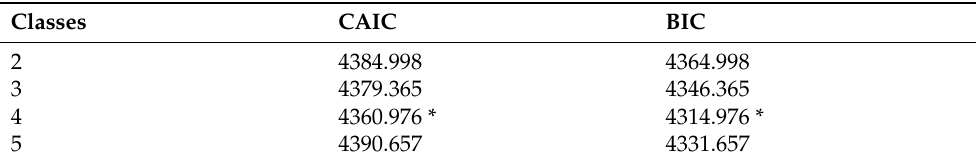
Table 6. Optimal number of Latent Classes.